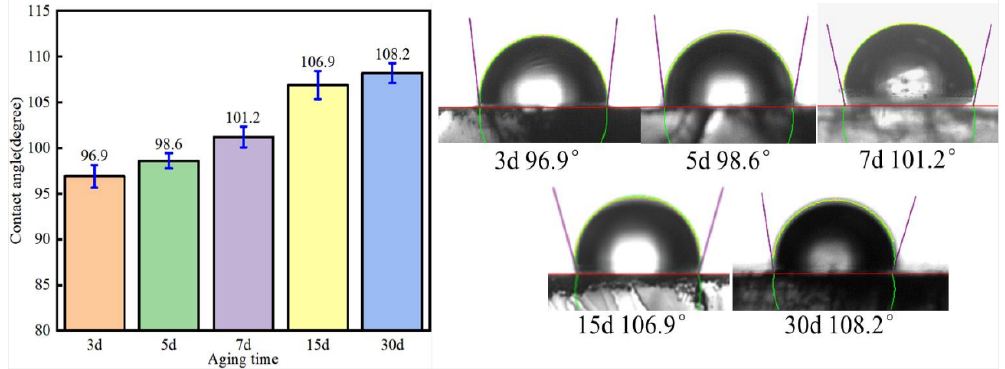
Figure 7. The aging time effect on the wettability of oil-wet calcite (25 °C).